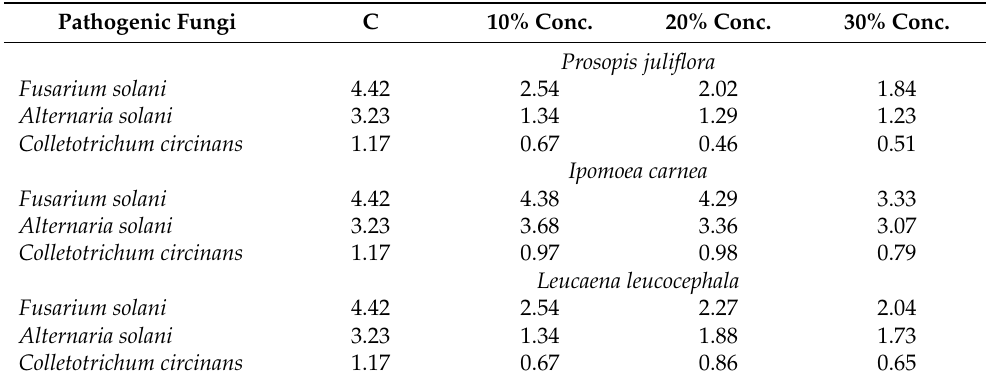
Table 3. Average daily growth (mm) of Fusarium solani , Alternaria solani , and Colletotrichum circinans , under in vitro conditions. These pathogenic fungi were treated with three concentrations of plant extracts (10%, 20%, and 30%), from the three invasive plant species. Pathogenic Fungi C 10% Conc. 20% Conc. 30% Conc.